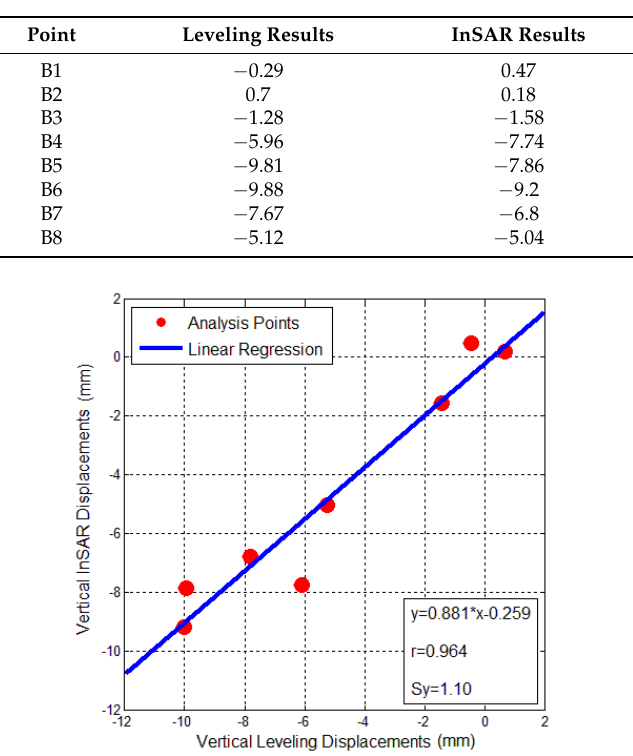
Figure 10. Ordinary Least Squares (OLS) Regression analysis in vertical displacements of the Bohai Building between extracted from InSAR and surveyed from leveling.